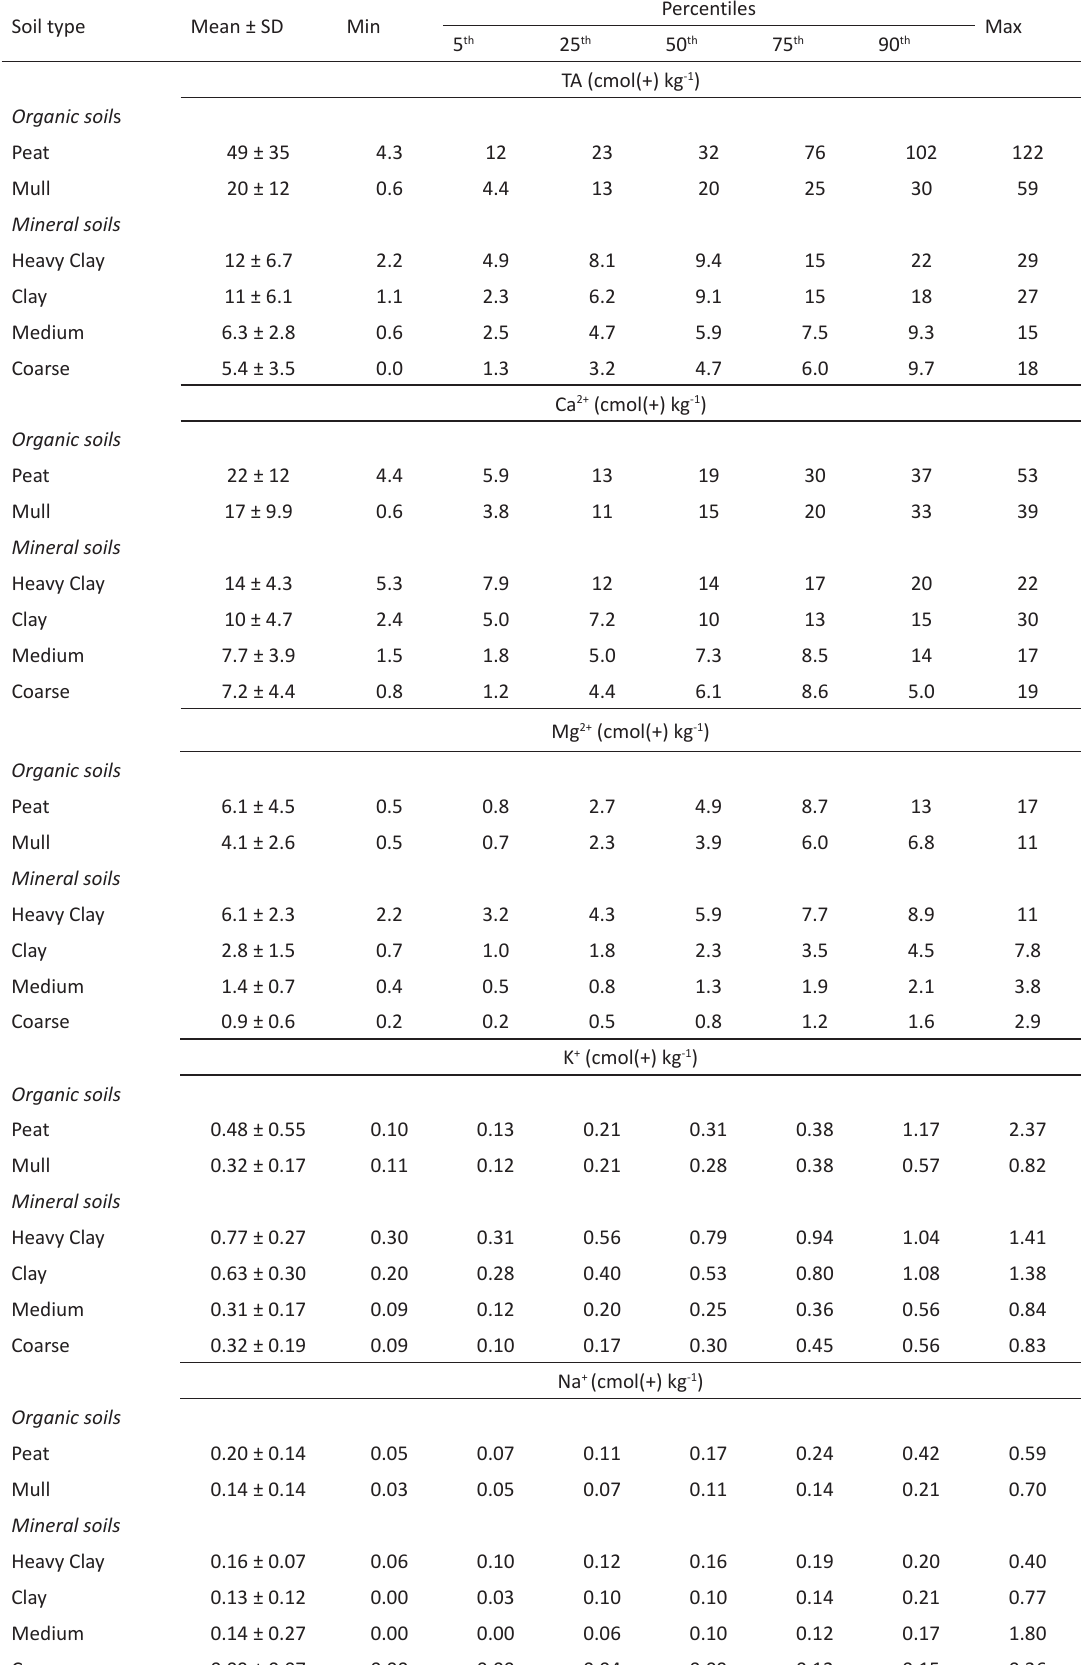
Table 5. General statistics for contents (cmol(+) kg -1 ) of titratable acidity (TA; H + + Al 3+ ) and exchangeable calcium (Ca 2+ ), magnesium (Mg 2+ ), potassium (K + ) and sodium (Na + ) in different soil types (see number of soil samples (n) in Table 2 and